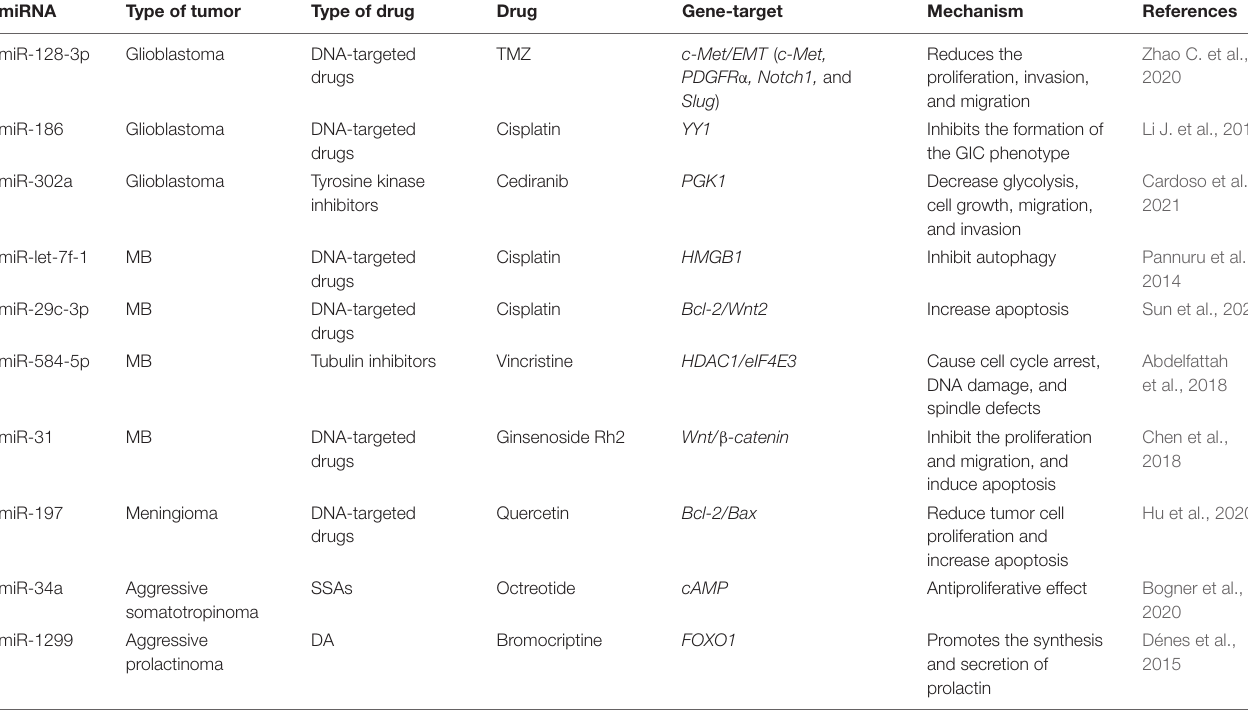
FIGURE 2 | MiR-21 involved in radio- and chemoresistance in glioblastoma. This figure shows through which signaling pathways miR-21 may be involved in resistance to therapy in glioblastoma. TABLE 2 | MiRNAs involved in the regulation of chemotherapeutic and pharmacological drug treatment resistance in malignant primary brain tumors